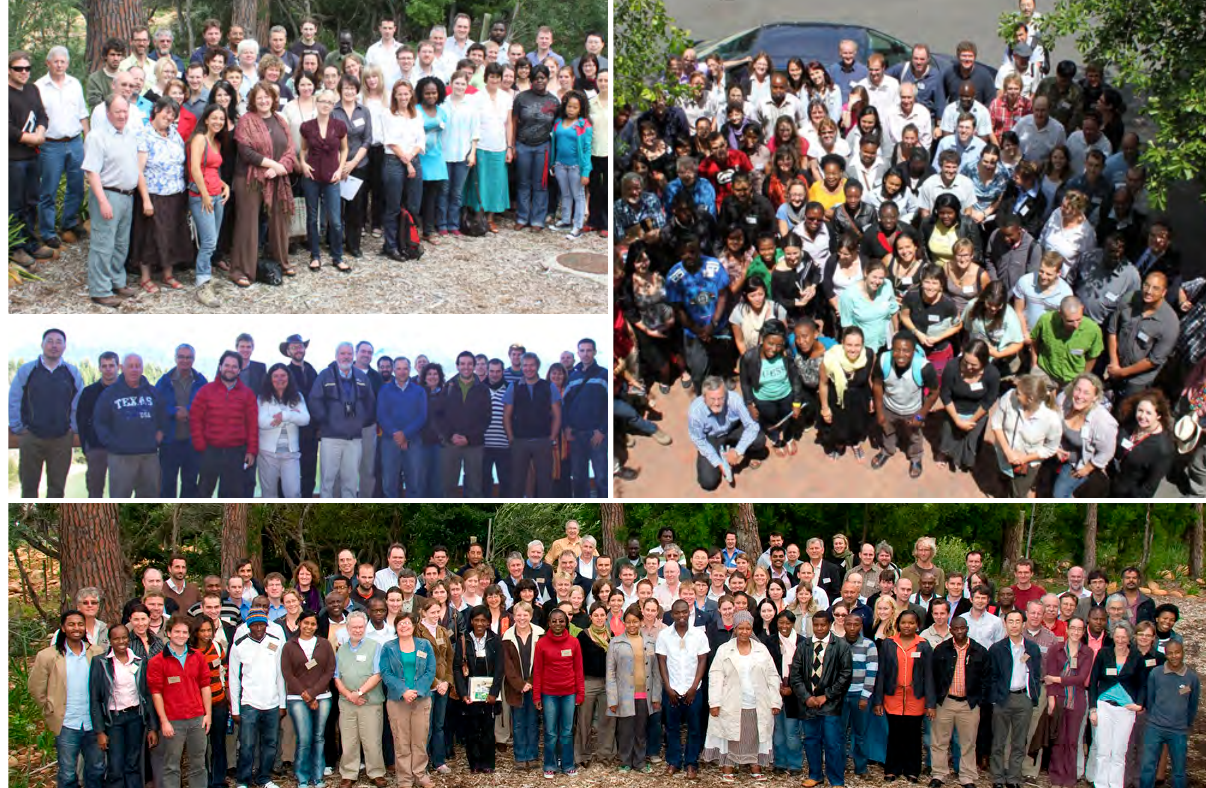
Figure 5: The Centre for Invasion Biology ensures contact with dispersed members by holding an Annual Research Meeting, which all core team members and all postgraduate students are required to attend (top right). In addition, focused international gatherings are convened to address and synthesise topics of importance and global interest: (top left) participants at a workshop on introduced Australian Acacia species; (middle left) participants at a workshop on the ecology and management of tree invasions; (bottom) participants at a workshop at which a global synthesis of invasion ecology was undertaken to mark the 50th anniversary of the publication of Charles Elton’s pioneering work on invasion biology (see Table 2 for